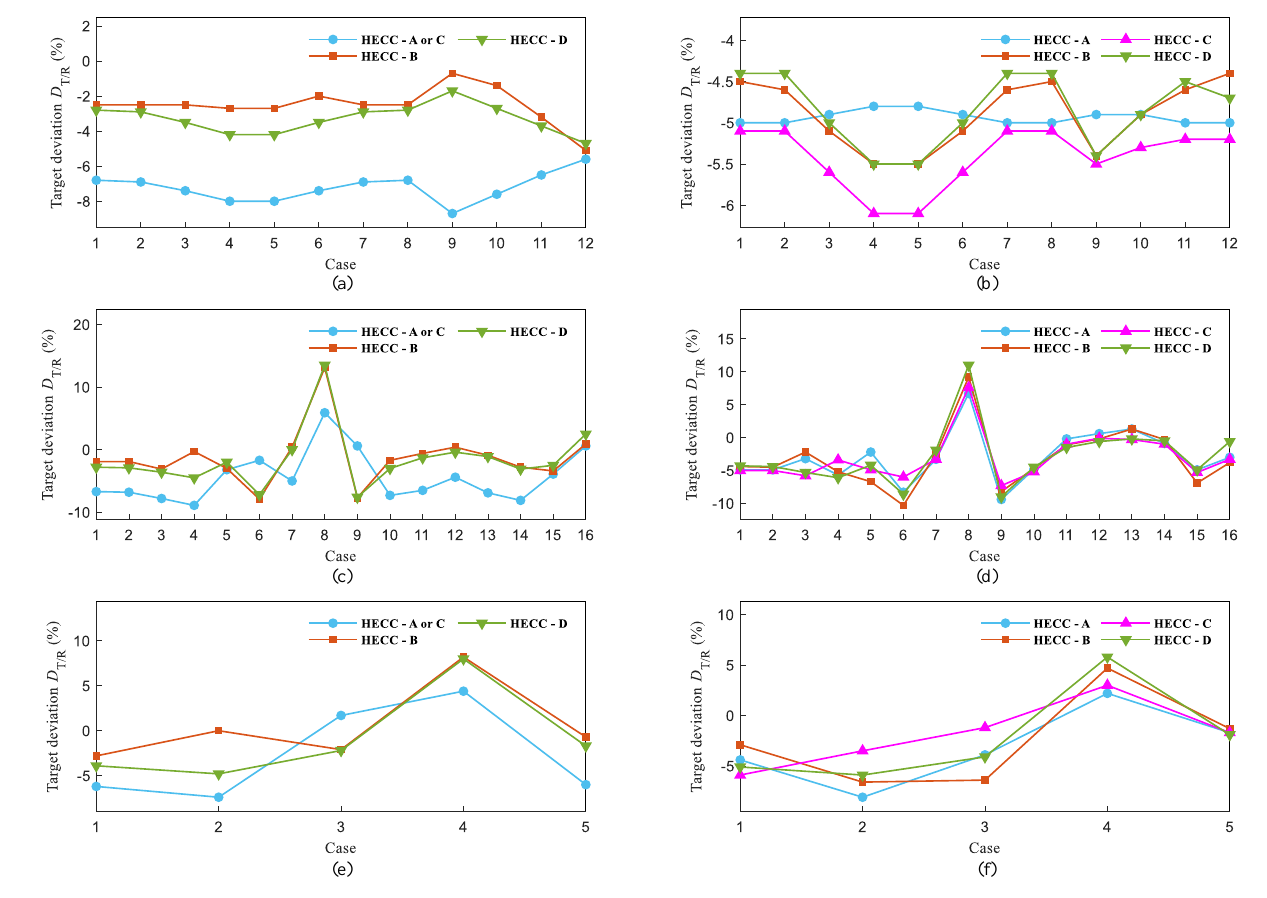
Figure 2. Target deviations for cases in three types of numerical experiments: ( a , b ) cases for the first type without and with maximum area limitations; ( c , d ) cases for the second type without and with maximum area limitations; ( e , f ) cases for the third type without and with maximum area